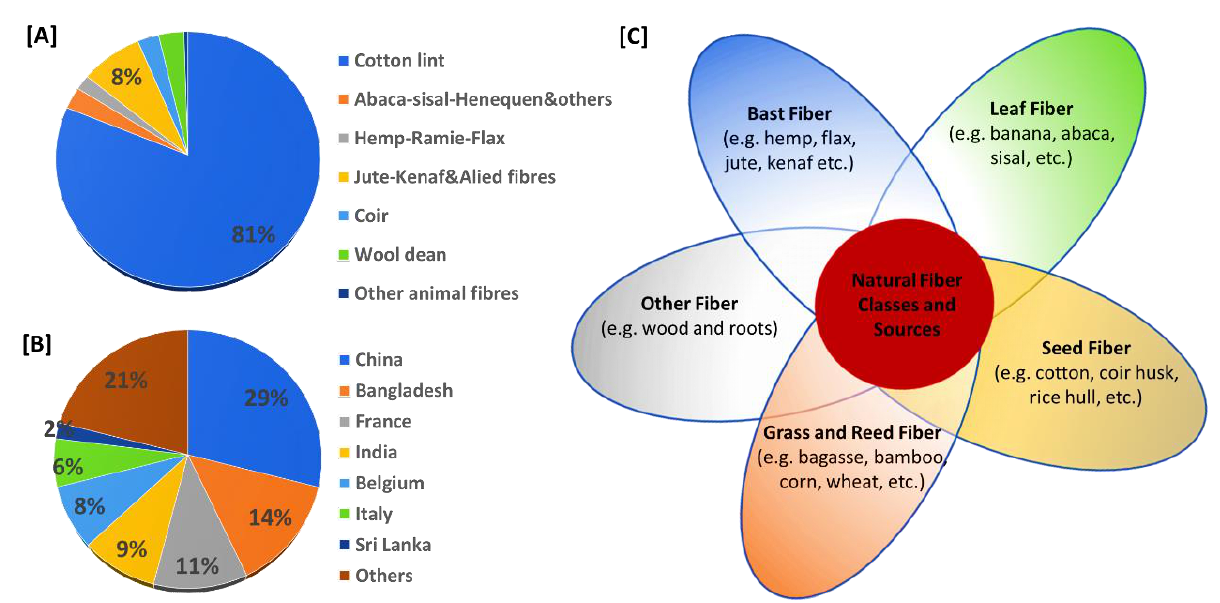
Figure 1. Types of natural fibers, their classifications, sources, and supply. ( A ) Distribution percentage of different types of natural fibers used as of 2018; ( B ) natural fiber supplies; and ( C ) classes of natural fibers and their sources (adapted and modified from [8,9]).